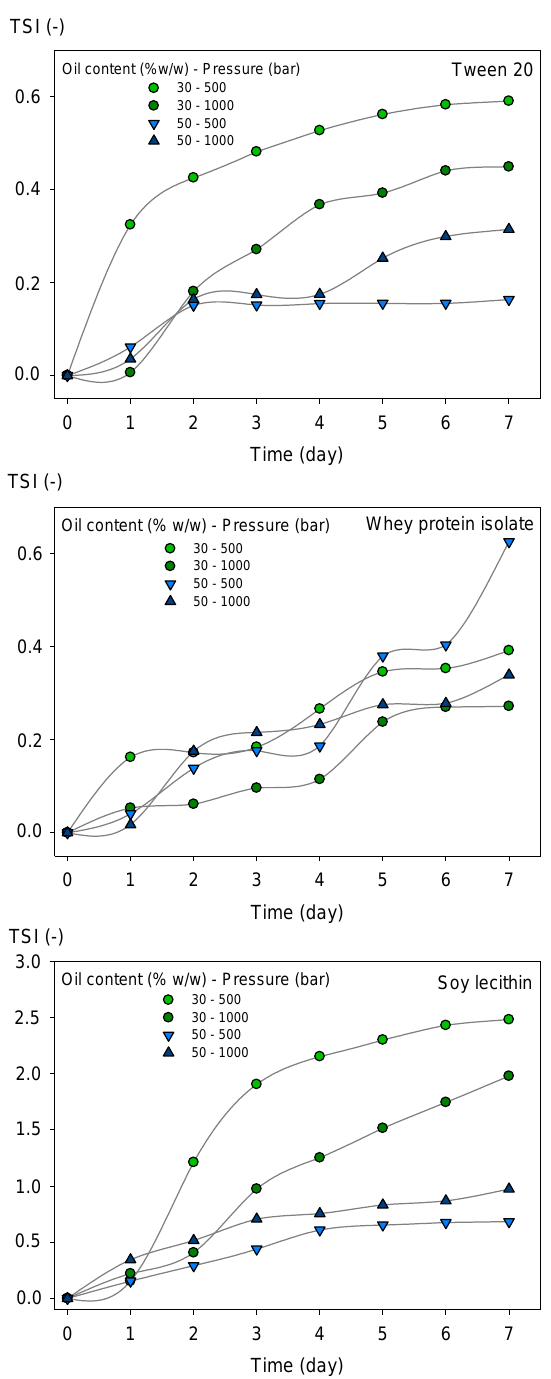
Figure 3. Turbiscan stability index (TSI, dimensionless) of emulsions fabricated at different process conditions and stabilized by the three surfactants studied. Lines are only guide for the eye.